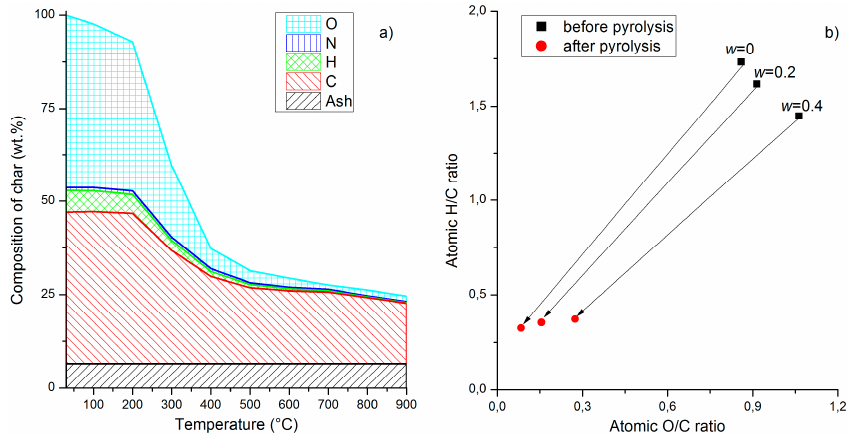
Figure 5. Composition of char after pyrolysis of beet pulp at different temperatures referred to initial weight of the sample ( a ) and changes of atomic H/C and O/C ratio before and after pyrolysis at 600 °C for mass fraction of defecation lime in sample from 0 to 0.4 ( b ).